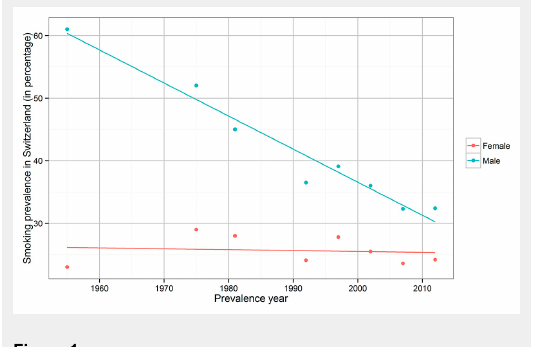
Trends in lung cancer incidence in women by histological type in the Canton of Zurich, Switzerland, 1980–2010. Rates are age adjusted to the standard European population. NOS = not otherwise